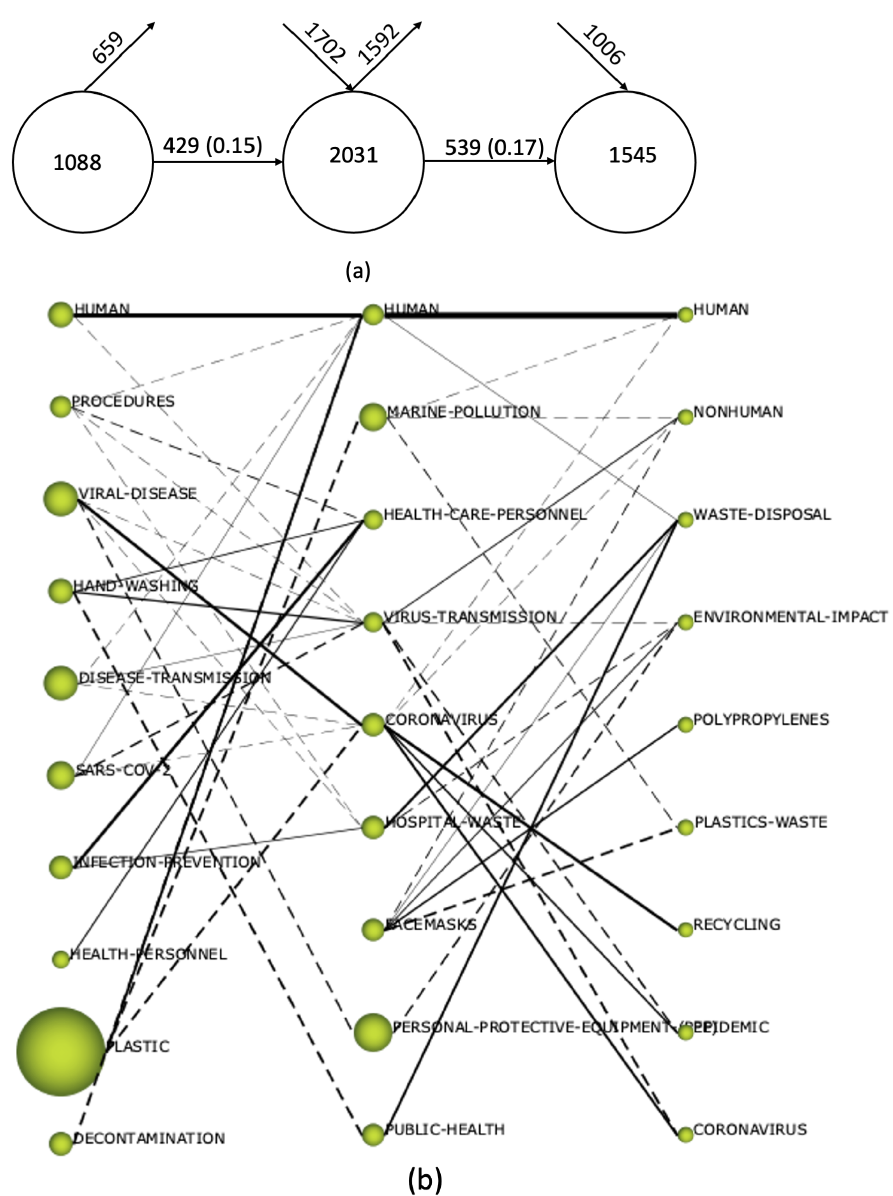
Figure 13. Representation of the evolution of topics over time in the research field using overlay graph ( a ); thematic evolution map in terms of average citations ( b